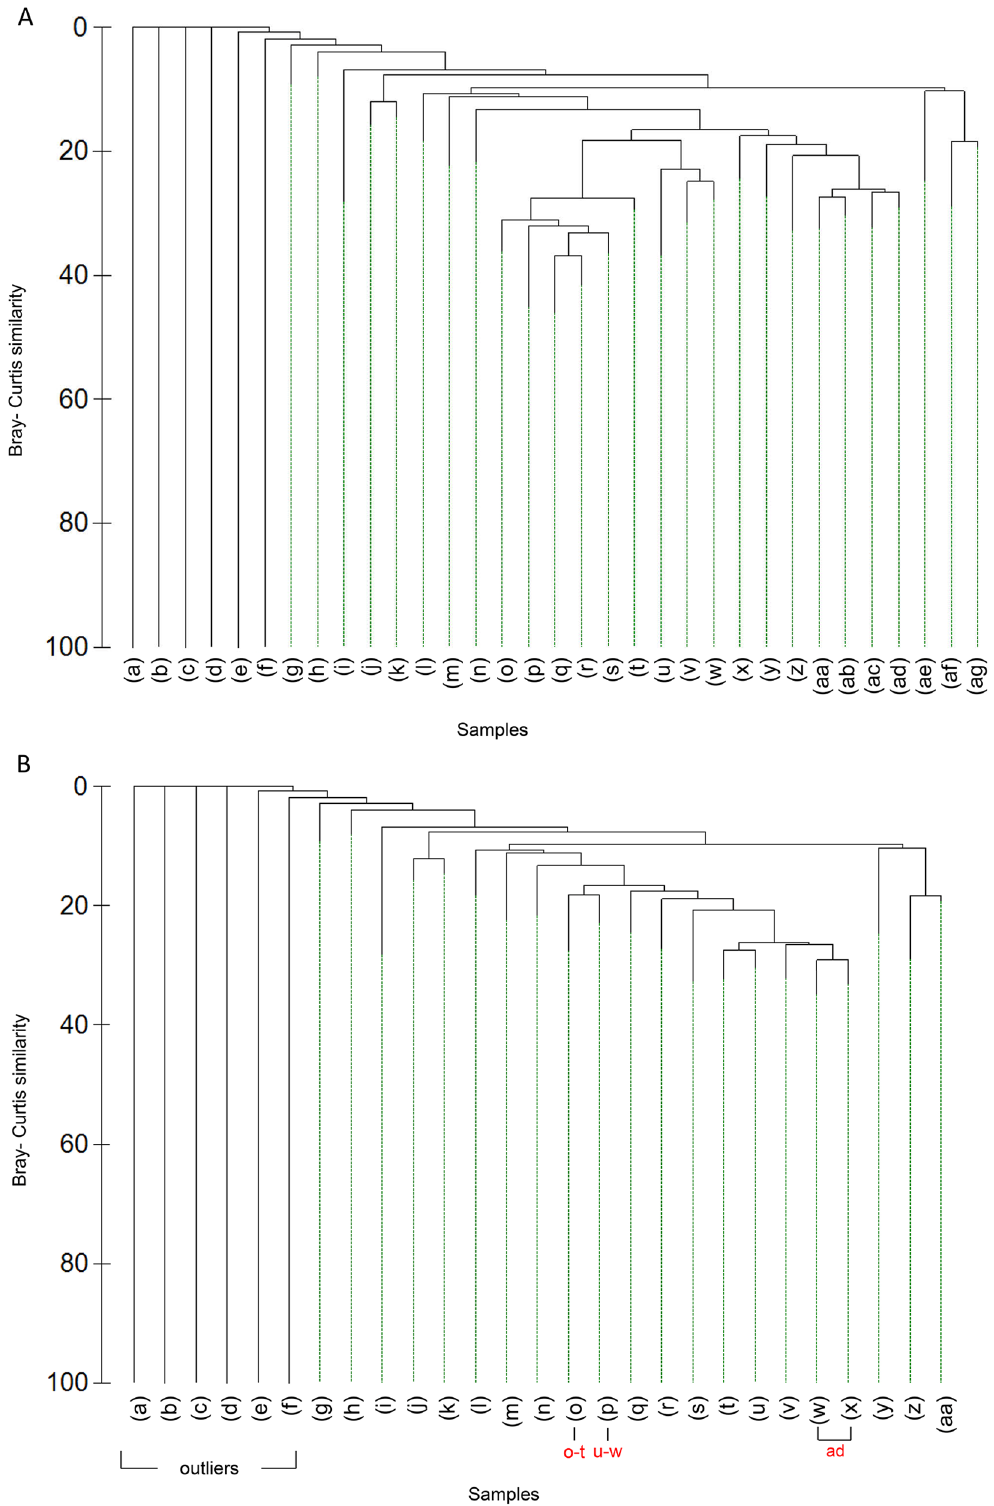
Fig 3. Dendrogram of hierarchical cluster analysis of species data, clusters identified using the SIMPROF routine (p < 0.01). Dendrogram (A) shows the SIMPROF cluster results prior to splitting and consolidation of clusters and (B) shows re-labelled clusters after splitting and consolidation. Those clusters that were combined or split from Fig. 3a are labelled in red. SIMPROF clusters are collapsed for ease of interpretation and are represented by green dashed lines. Grey lines represent SIMPROF identifying with no significant internal structure. doi:10.1371/journal.pone.0124815.g003 PLOS ONE | DOI:10.1371/journal.pone.0124815 May 18,